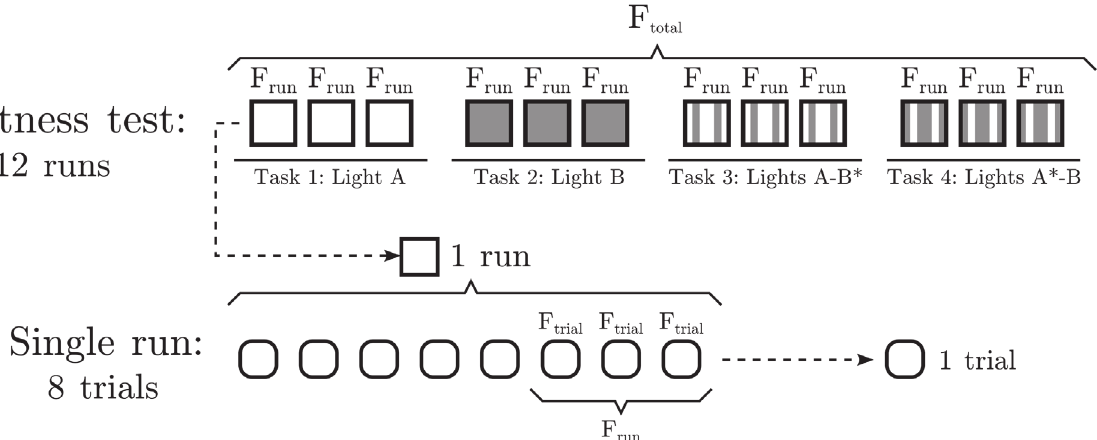
Fig 2. Structure of the task performed by the genetic algorithm. Each agent is tested for 12 different runs (3 for one of the 4 tasks), averaging their fitness values to obtain the total fitness. Each run consists of 8 different trials. For each trial, two lights are presented to an agent during a period of 125 s . Only the three last trials of a run are taken into account for computing the fitness of the run in order to avoid penalizing slow plasticity.